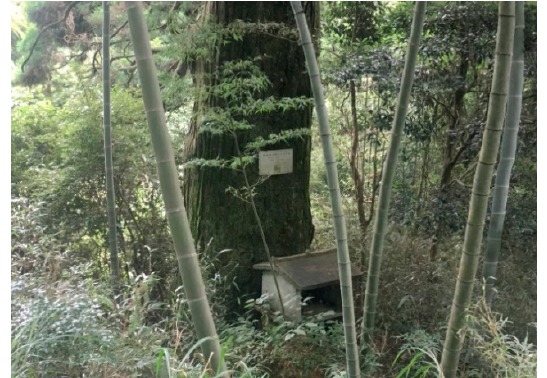
Figure 4. Open-air memorial tablet in Lingtou Village.